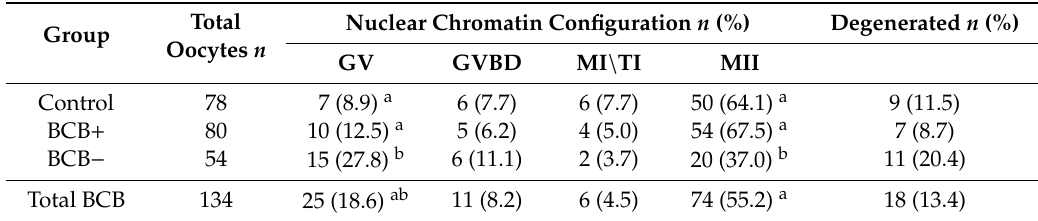
Table 1. Meiotic progression of cat oocytes obtained from ovaries of anestrus cats selected by Brilliant Cresyl Blue (BCB).